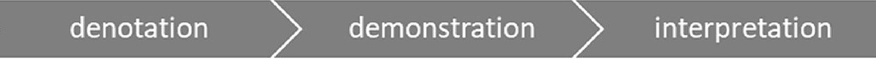
Fig. 3. Cognitive process based on the cartography model (based on Hughes,